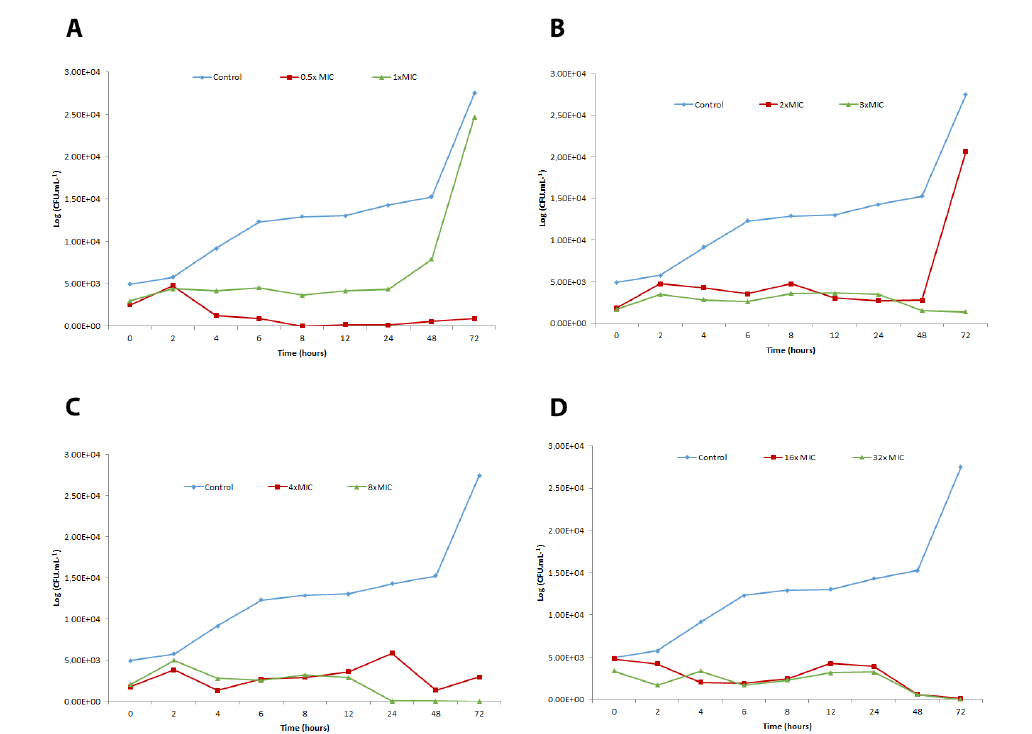
Figure 3. Time-kill curves for lireodenine against strain 57 of Cryptococcus neoformans complex. Eight doubling dilutions are plotted, the highest concentration corresponds to 32 × MIC as measured with the EUCAST microdilution method, and the blue line represents growth in absence of lireodenine. The compound was added at timepoint 0 and monitored until 72 h. The limit of detection in the assay was 33 CFU/mL. CFU: colony forming units; MIC: minimum inhibitory